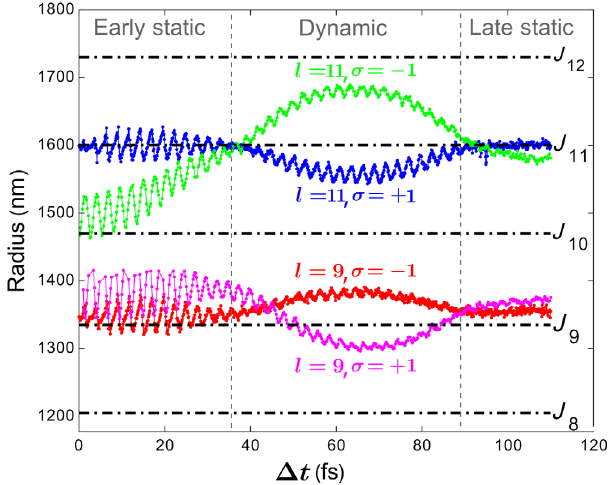
FIG. 8. Radiusofthecentralpatternasafunctionofthedelay , Δ t . The horizontal dashed lines represent the radii of the main lobes of the corresponding Bessel functions [ J 8 ð k Each curve corresponds to a vortex-light configuration presented in Table I. The experimental data for the curves are presented in the insets of Figs. 3(c) and 3(d) in the main text and in Figs. S2 C and S2 D of SM [40]. The blue curve is obtained by creating a vortex- light configuration that was also used to observe the dynamics of a plasmonic vortex in Ref. [10].